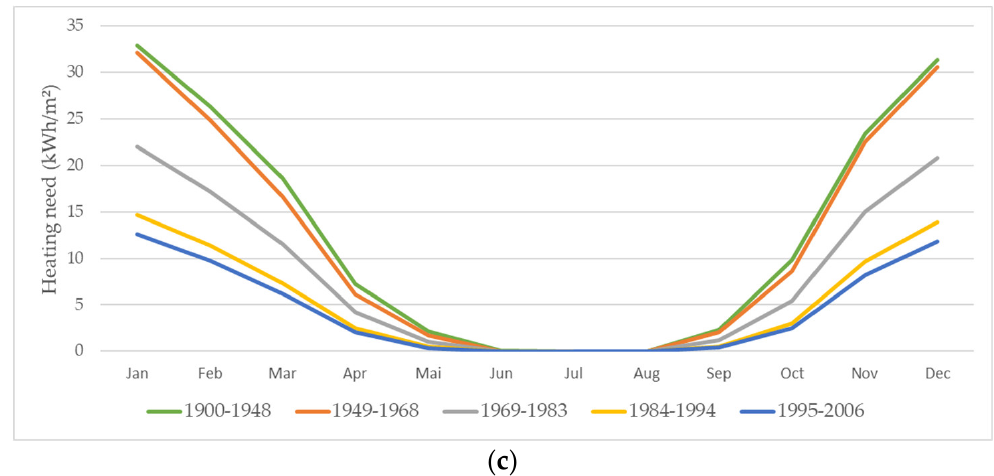
Figure 6. Monthly specific ( a ) heating and ( b ) cooling energy needs for seven building types and ( c ) heating energy needs for five building age classes.